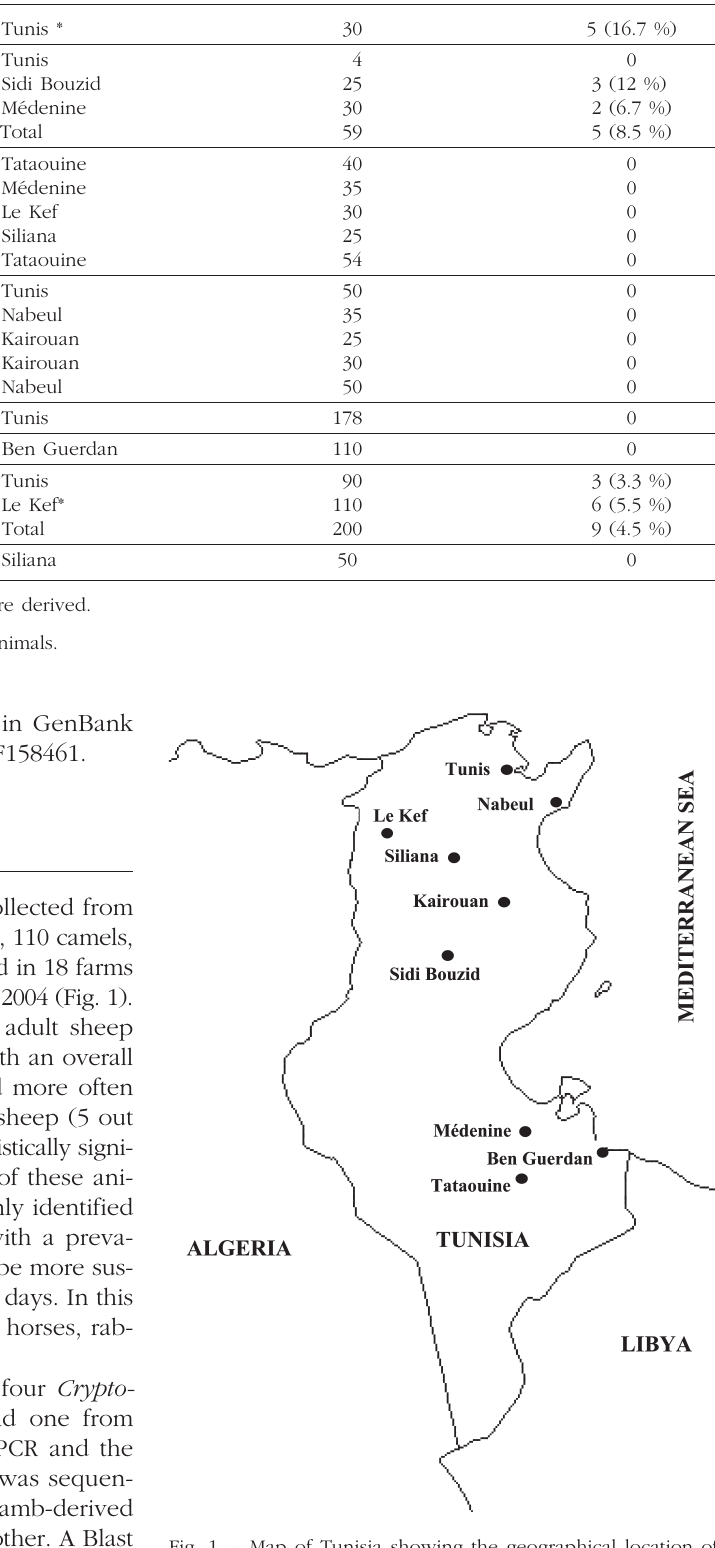
Fig. 1. – Map of Tunisia showing the geographical location of the different farms from where sampled animals were